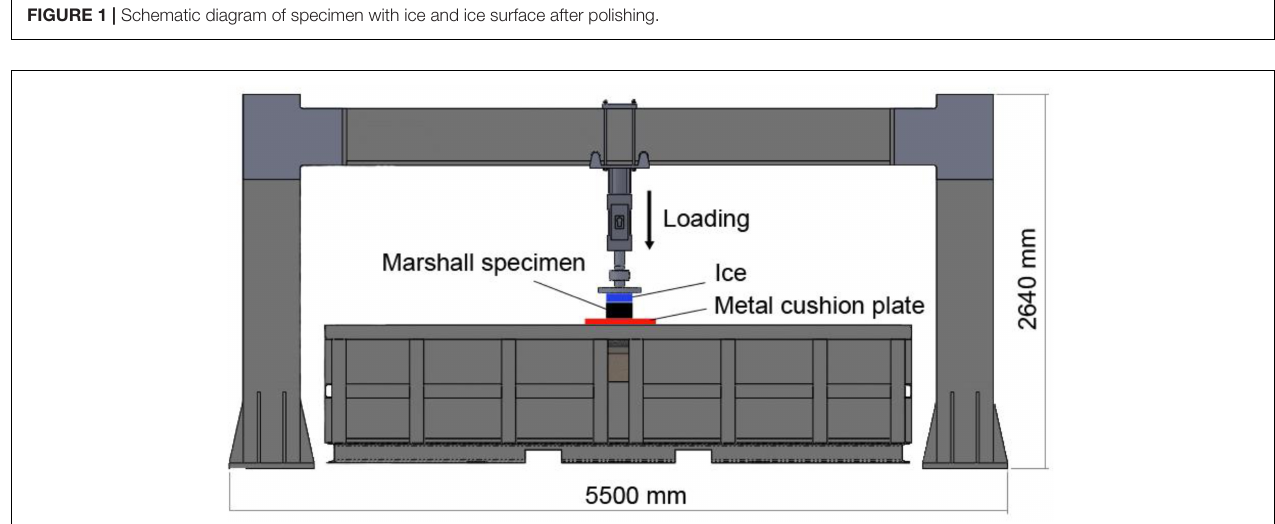
FIGURE 2 | Schematic diagram of uniaxial unconfined compressive